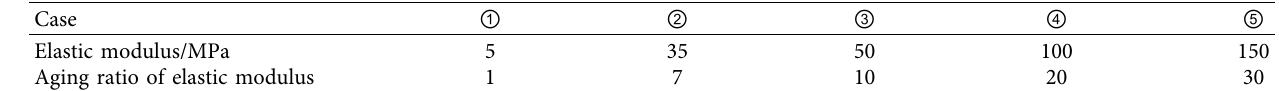
Table 2: Different aging ratios of elastic modulus of rubber